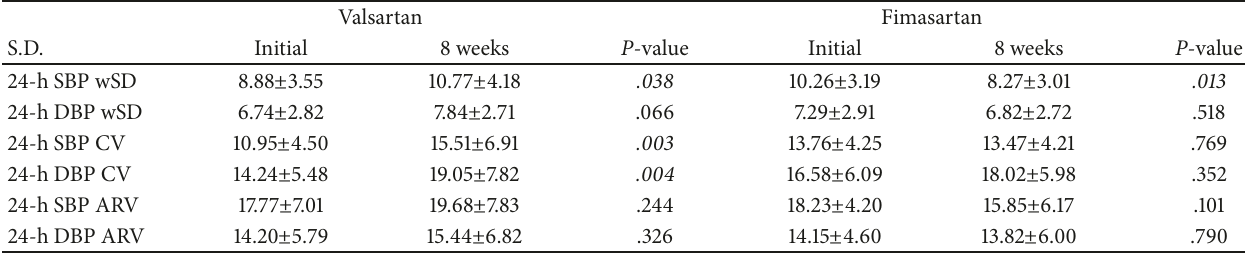
Table 4: BPV-the other